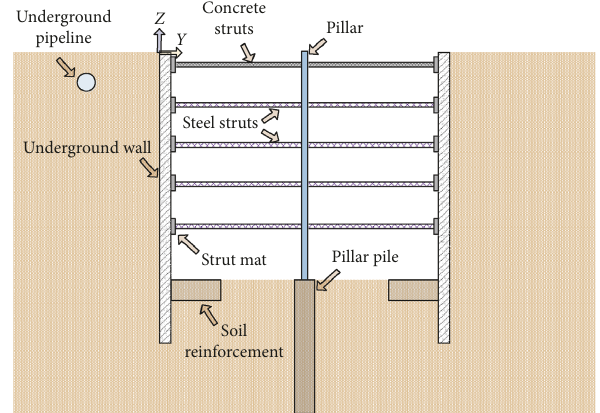
Figure 5: The cross-sectional Y - Z simplified model view of the